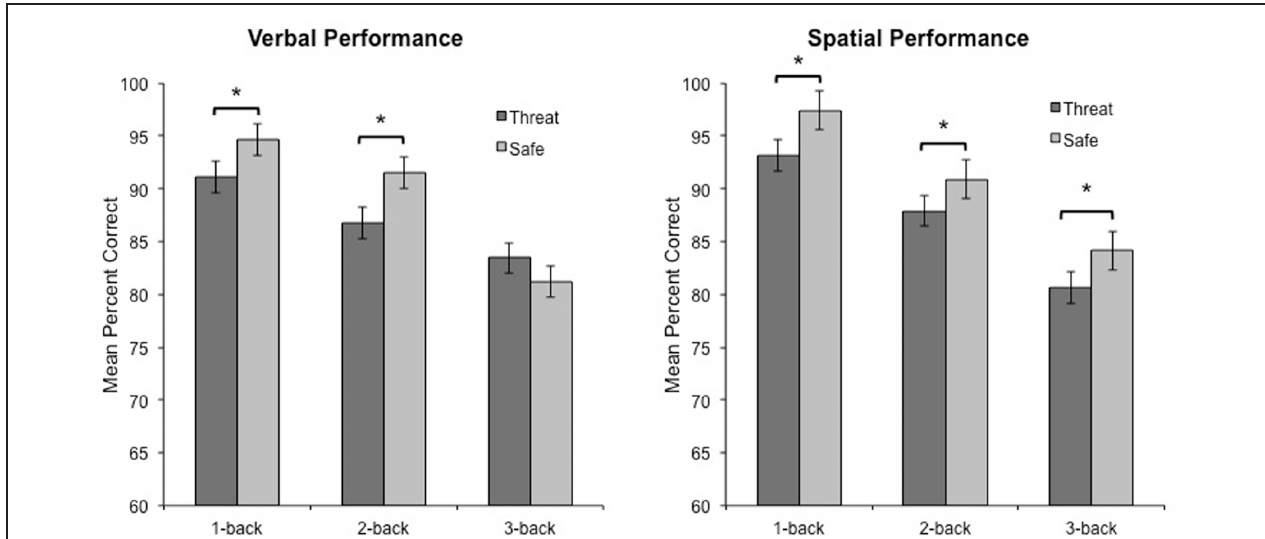
FIGURE 2 | Verbal and spatial n -back performance during threat and safe. Verbal performance was impaired during threat compared to safe when participants were engaged in low-load tasks (1-back and 2-back), but not high-load tasks (3-back). In contrast, spatial performance was impaired during threat compared to safe when participants were engaged in any task, irrespective of difficulty. Error bars represent the